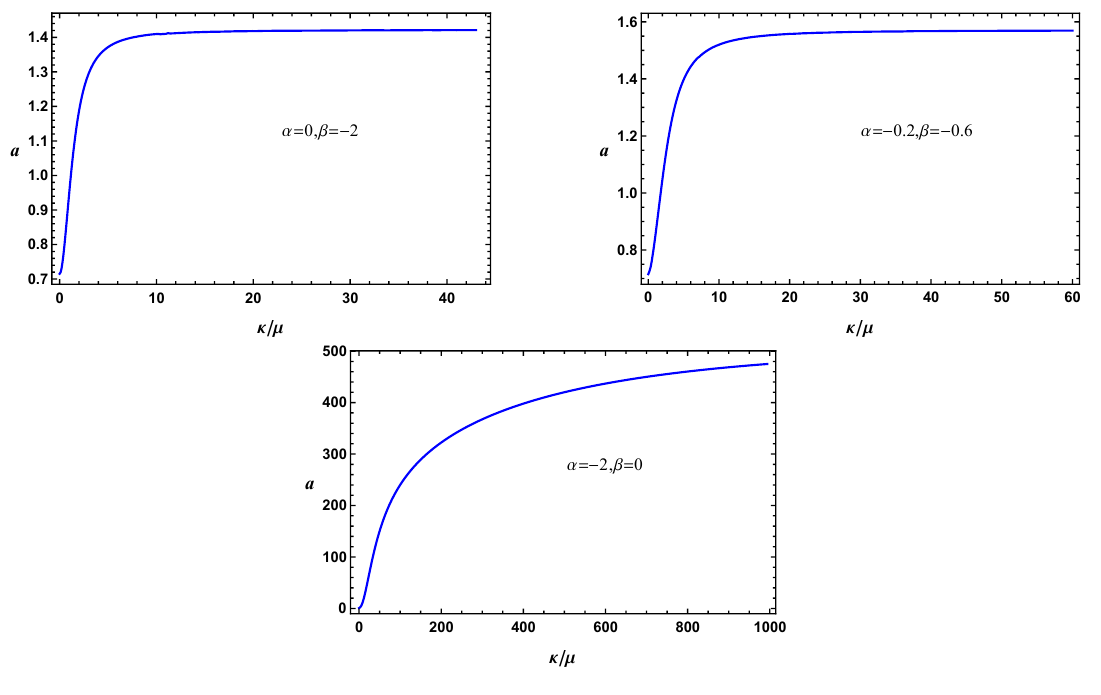
Figure 14 . The slope of c 1 /c 2 with respect to κ/µ